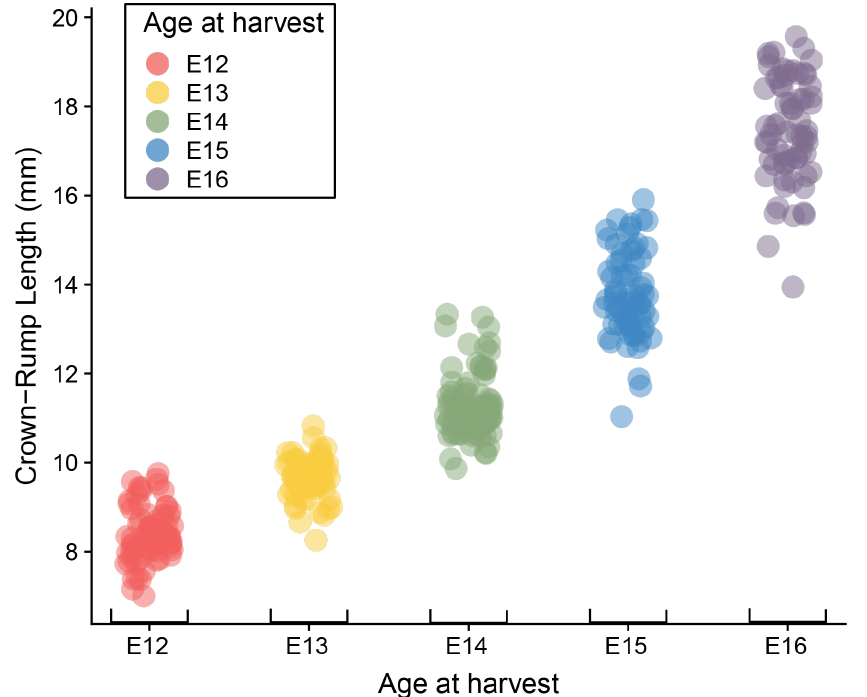
Figure 2. Plot of Crown-rump length by age at harvest. Dots represent individual specimens and are colored according to age at